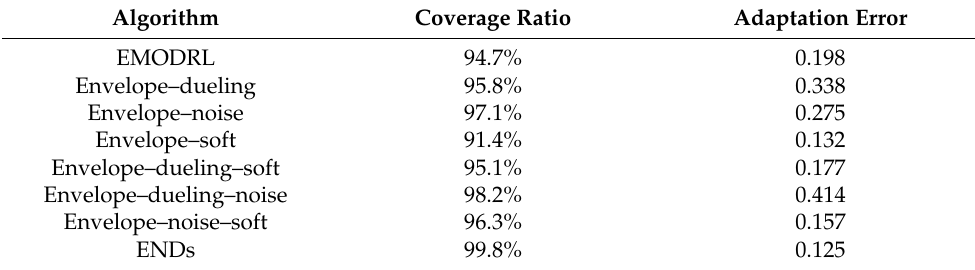
Table 2. Comparison of coverage ratio and adaptation error among different